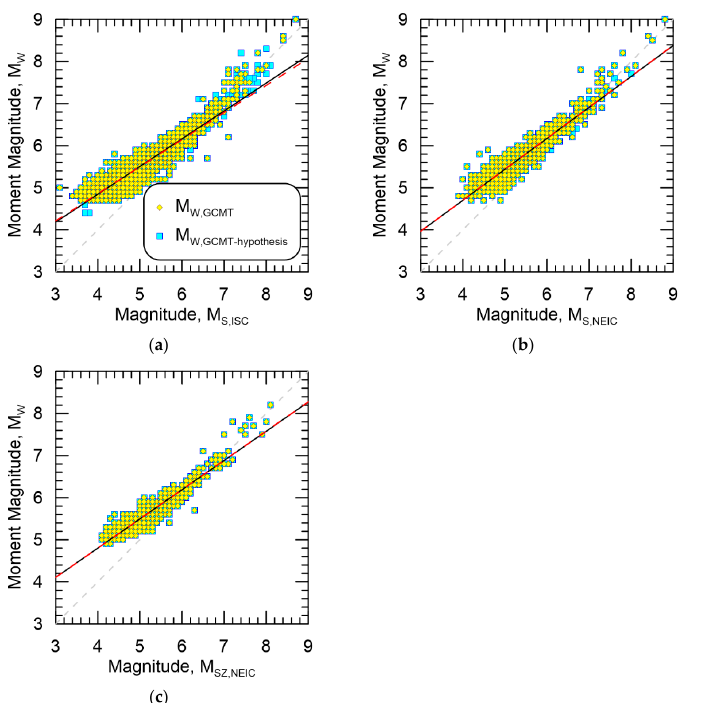
Figure 5. Resultant magnitude homogenization regressions for M W,GCMT ‐ hypothesis against ( a ) M S,ISC , ( b ) M S,NEIC , and ( c ) M SZ,NEIC . Data from M W,GCMT are also shown. Black line is the regression against M W,GCMT ‐ hypothesis while the dashed red line is the regression against M W,GCMT . The resultant magnitude homogenization regressions for all body wave magnitude types considered herein, i.e., m b,ISC , m b,NEIC , m b,DJA , are shown in Table 5. There were signif ‐ icantly more data points for regression across the board and increasing σ as the moment magnitude pool went from M W,GCMT to M W,GCMT ‐ hypothesis . Table 5. Magnitude homogenization regression results from all moment magnitude pools for body wave magnitude types.